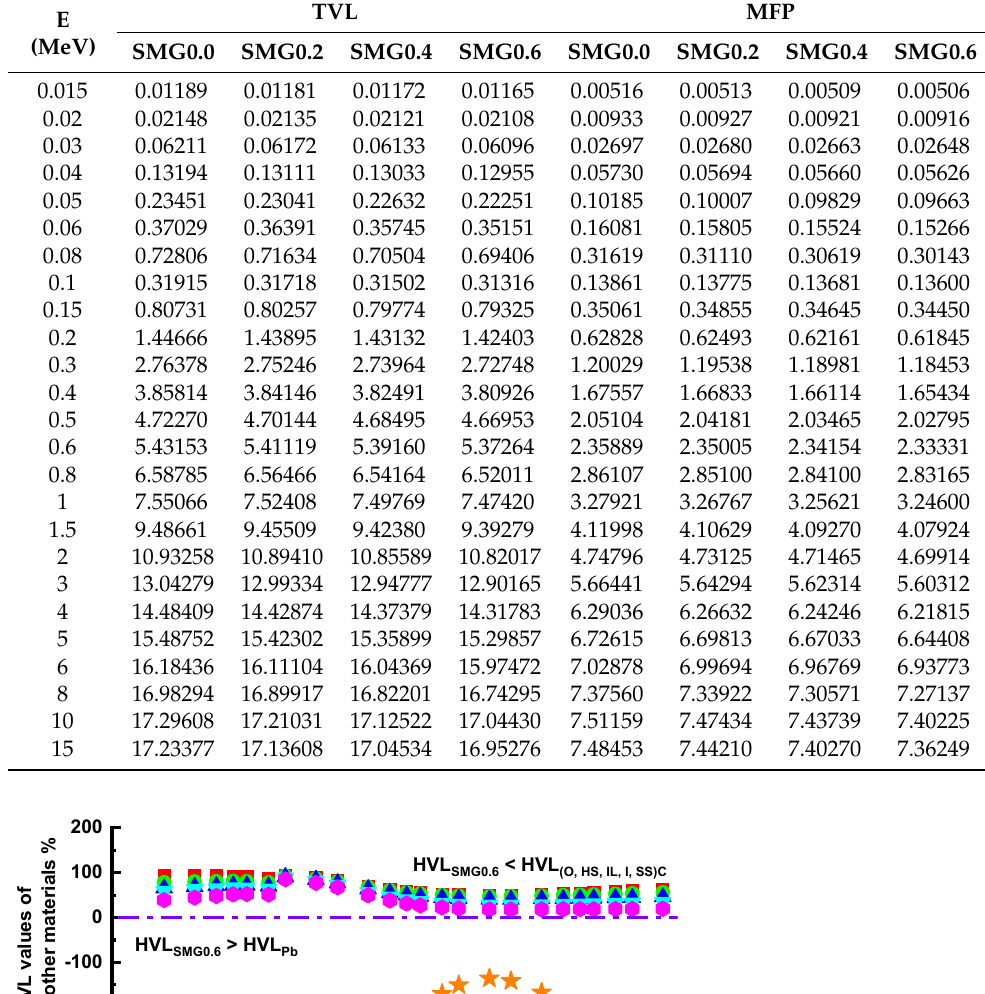
Table 2. The results of the mean free path-MFP and Tenth value layer -TVL of the studied samples.